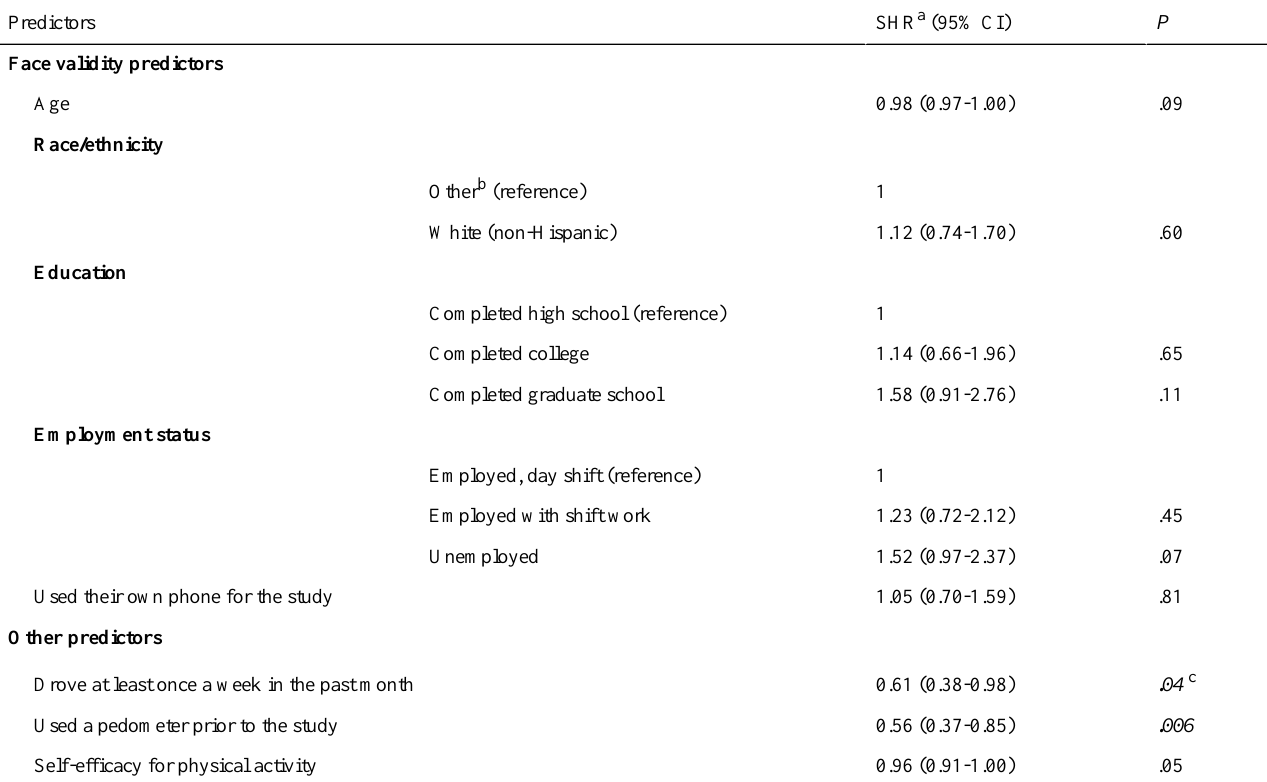
Table 2. Multivariate subdistribution hazard models predicting time to failure during the run-in period